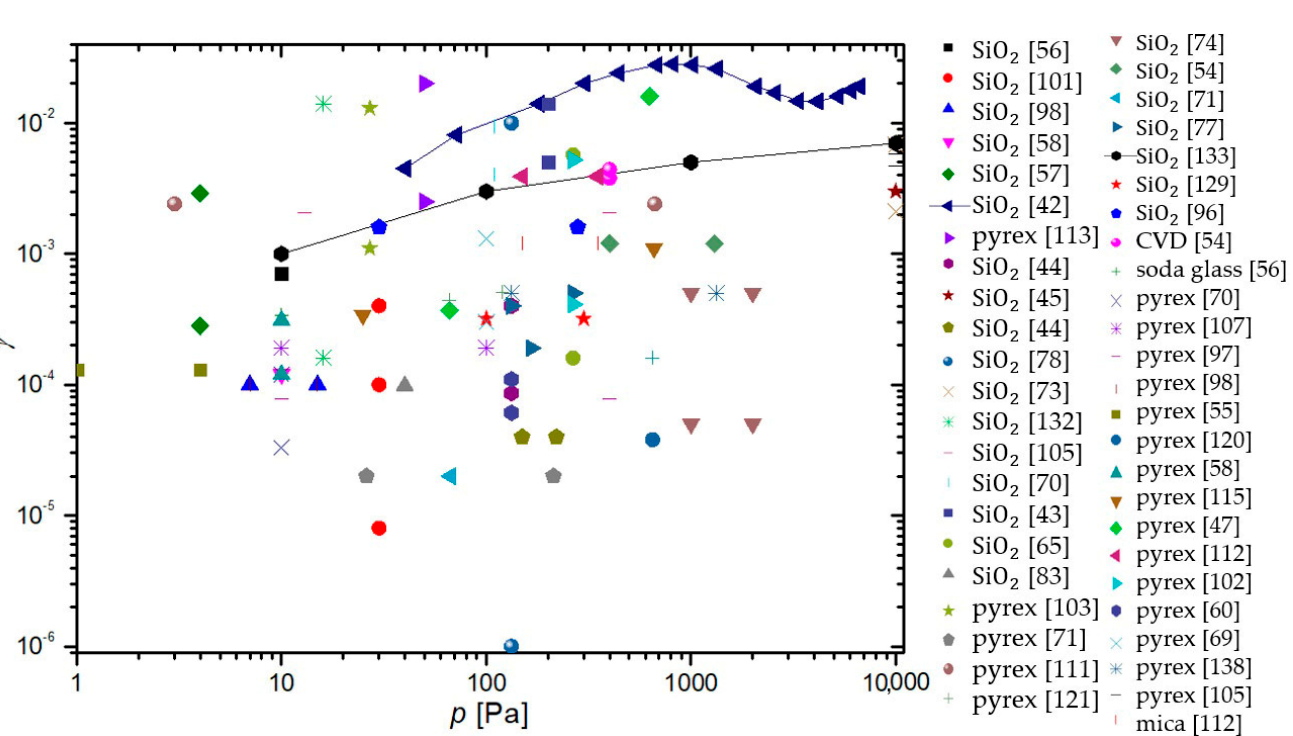
Figure 21. Recombination coefficient ( γ ) of neutral oxygen atoms versus surface temperature ( 𝑇 (cid:3046) ) for glass surfaces.